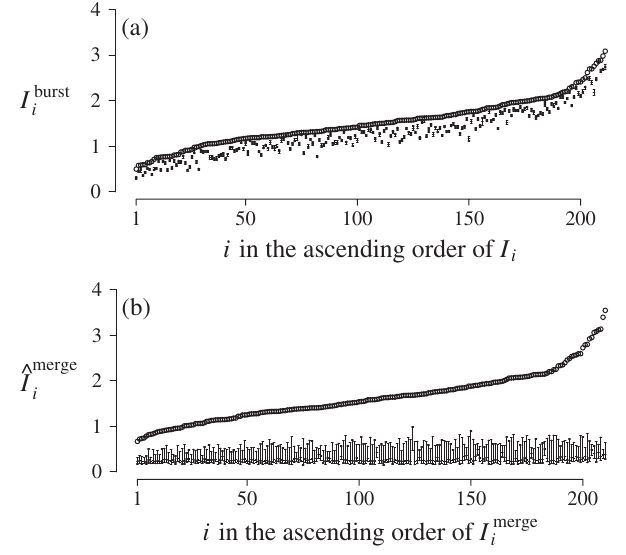
FIG. 9. Results of the bootstrap tests for D of (a) shuffling and (b) merging of the partner sequence.